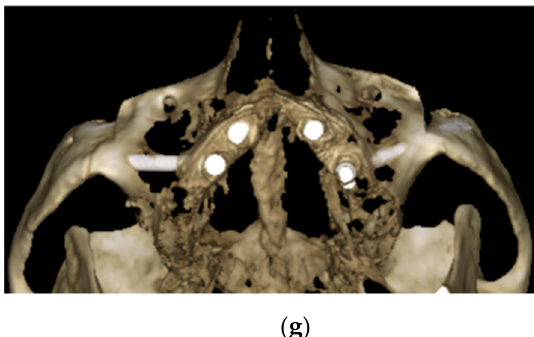
Figure 1. ( a ) Atrophic alveolar bone crest seen in a preoperative three-dimensional reconstruction CBCT image. ( b ) Atrophy of edentulous alveolar crest seen in an intraoral clinical image. ( c ) Placement of two posterior zygomatic implants (Branemark System Zygoma®, Nobel Biocare, Sweden). The coronal part of the zygomatic implant remains in a palatal position, and buccal fenestration is presented. ( d ) Buccal-centered image showing the buccal and palatal bone graft (KeraOs ® , Keramat, Spain)) . ( e ) Buccal-centered image showing overlap of the resorbable collagen membrane (Creos Xenoprotect ® , Nobel Biocare) upon the bone graft. ( f ) Soft tissue healing at one month after implant placement. ( g ) Postoperative three-dimensional reconstruction CBCT image showing palatal and buccal bone regeneration around the implants at 6 months after surgery.